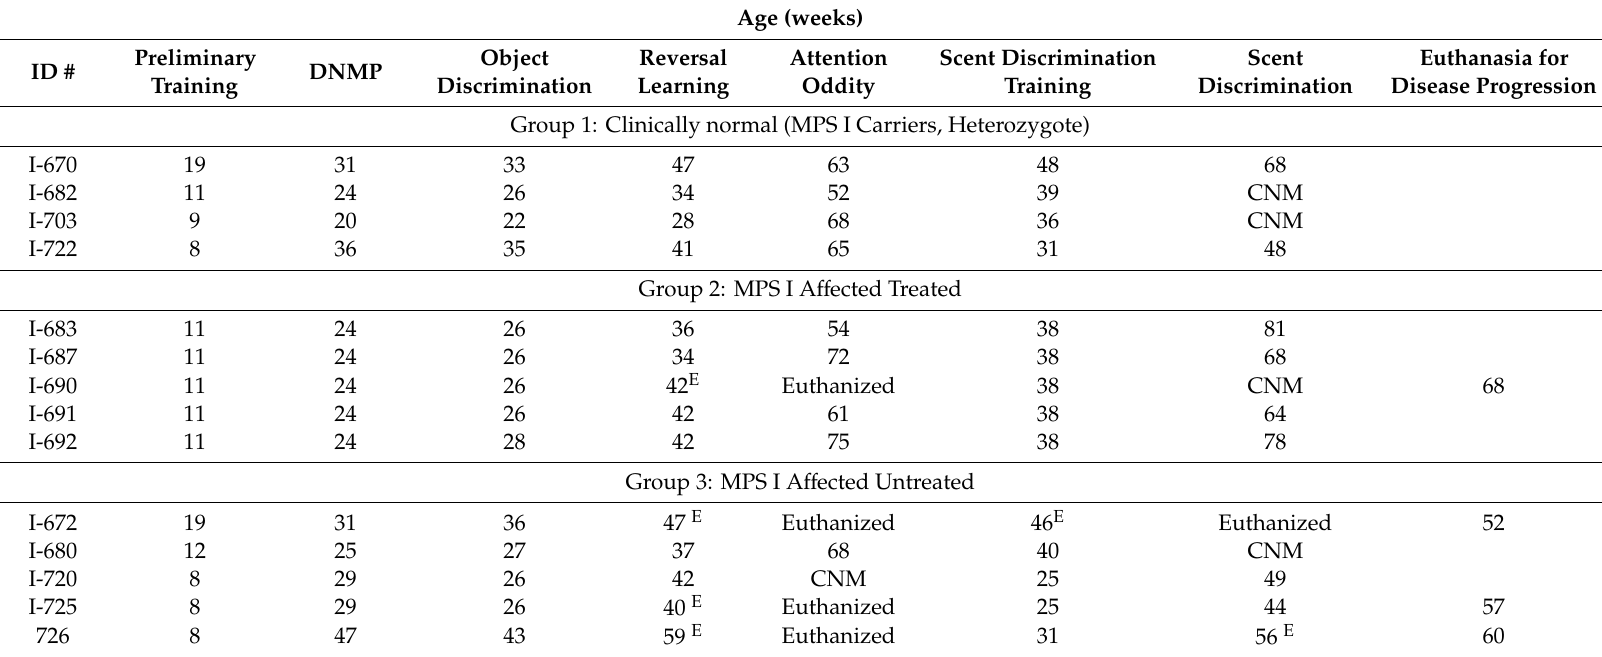
Table 3. Experimental timeline: age of dogs for which training, individual cognitive task, and euthanasia was